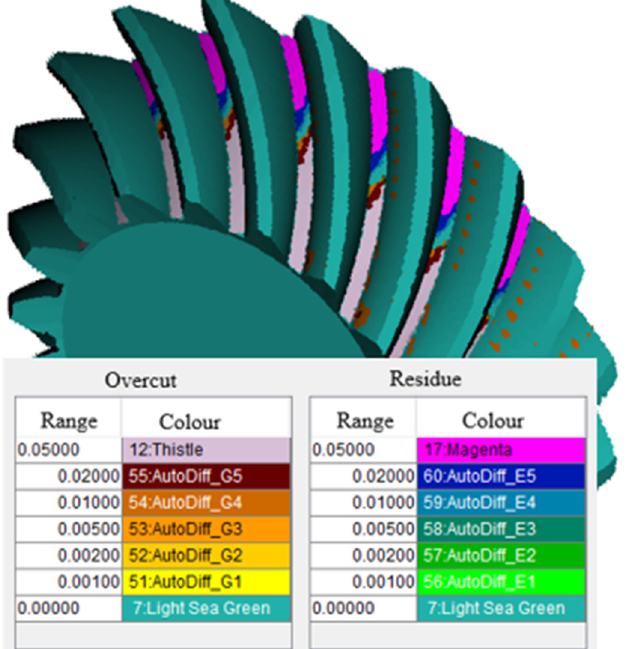
Fig. 12. Results of comparison.